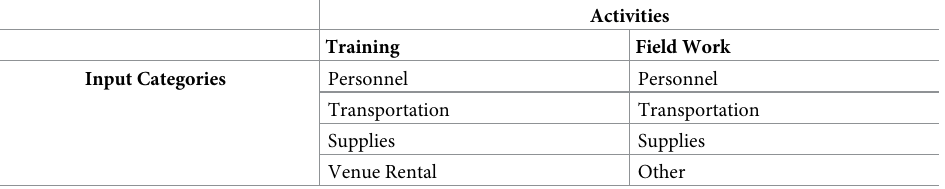
Table 1. Activities and input categories for trachoma impact and surveillance surveys, Amhara,